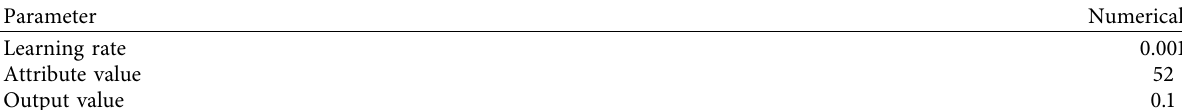
Table 2: Experimental condition data.